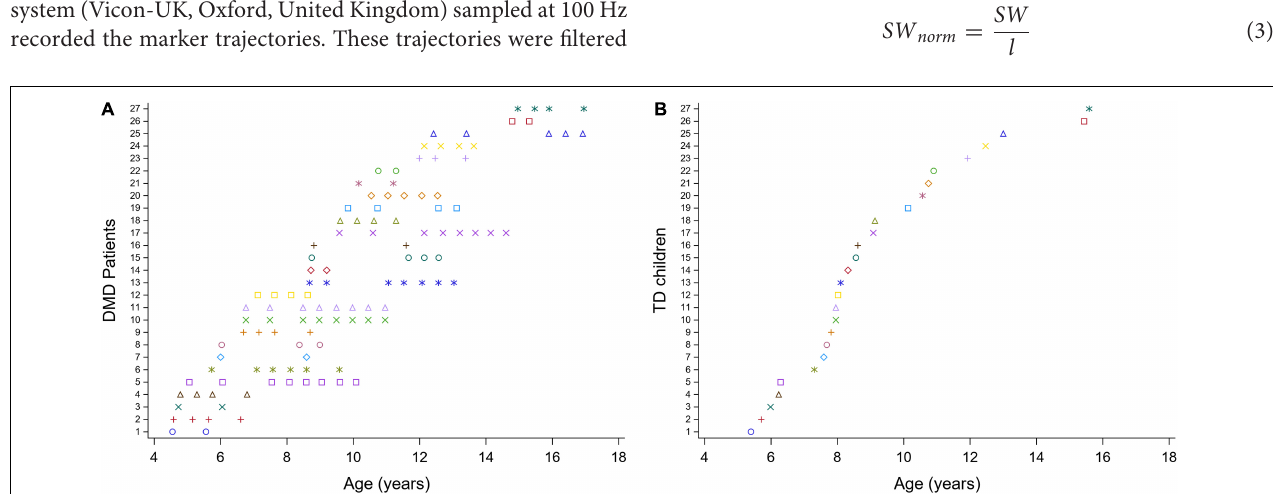
FIGURE 1 | Mixed cross-sectional longitudinal dataset. Overview of the ages at the included measurements for the children with DMD (A) and for the TD database (B) . Each color represents one patient. DMD, Duchenne muscular dystrophy; TD, typically developing.